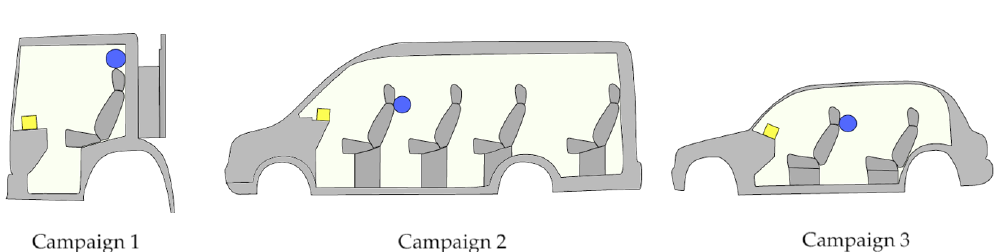
Figure 3. Schematic representation of the vehicles used in the three campaigns, with Campaigns 1, 2 and 3 being waste removal trucks, hospital transport vans and taxis, respectively. The yellow box represents the AirNode Generation One (AGO), and the blue circle represents the Air Filtration System